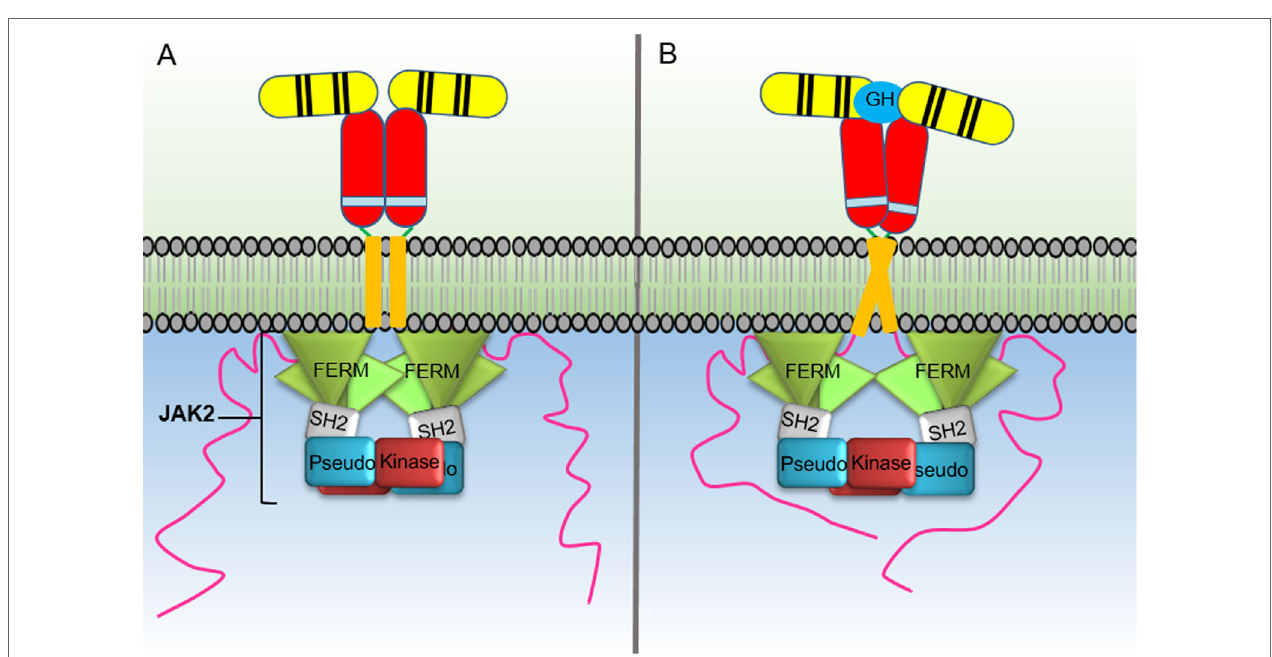
FiGURe 2 | Activation of the growth hormone receptor (GHR) by growth hormone. In the inactive homodimeric GHR, (A) the Janus kinase (JAK) 2 kinase domain (KD) is inhibited in trans by interaction with the pseudokinase domain from the JAK2 bound to the opposing receptor within the homodimer. GH binding to the GHR extracellular domain (b) results in conformational changes that cause the transmembrane domains to transition from a parallel interaction to a left-handed crossover interaction. These structural changes cause a separation of the intracellular domains to the Box1 and Box2 motifs and the associated JAK2 molecules. The movement of the associated JAK2s dissociates the inhibitory interaction of the pseudokinase from the KD and brings the two JAK2 KDs in close proximity resulting in trans phosphorylation and